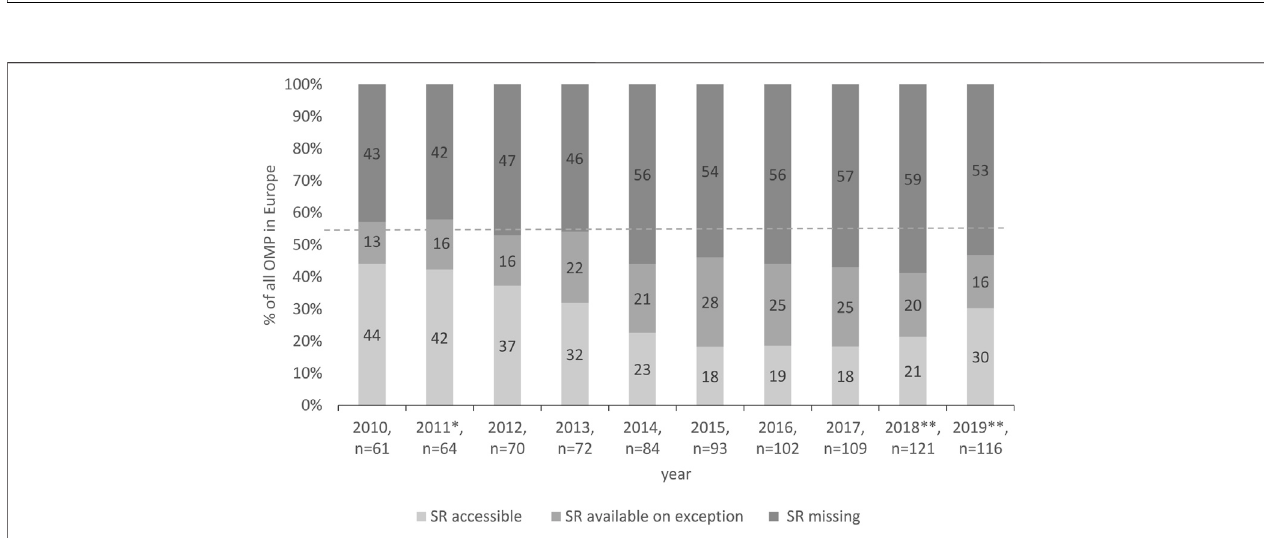
FIGURE 2 | Access to OMPs in Slovakia. * New pricing and reimbursement Act, ** Novelization of the pricing and reimbursement Act.